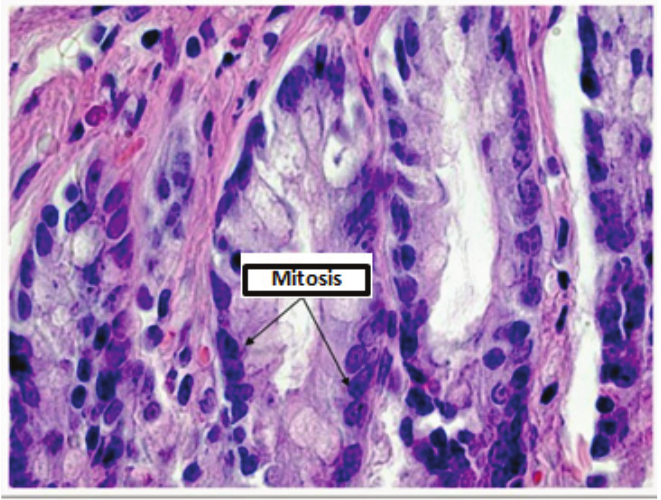
FIGURE 8 - Histological aspect of the animal 2 in the nitrite sham group showing mitotic figures in segment S